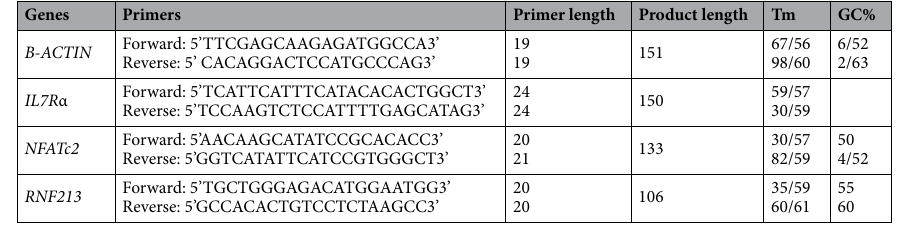
Table 2. Primer sequences used in qRT-PCR